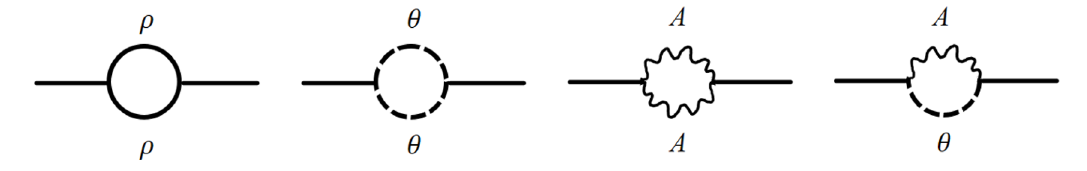
Figure 5 . The loop diagrams contributing to the finite part of Z polar (¯ φ, ξ ) in polar coordinates. There is no ghost loop because the polar-coordinate ghost is free and does not couple to the ρ